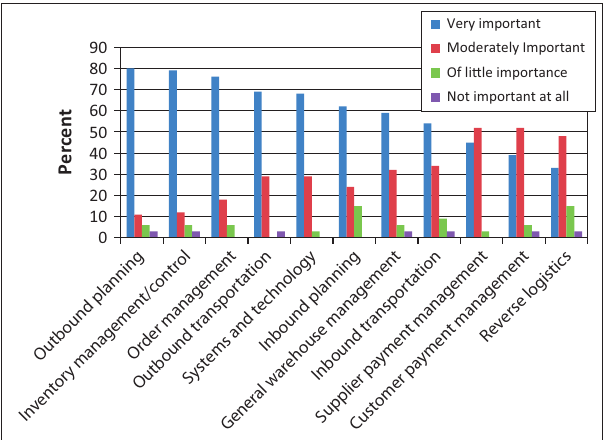
FIGURE 7: Importance of logistics functions to business success. FIGURE 5: Logistics functions outsourced by respondents and the involvement